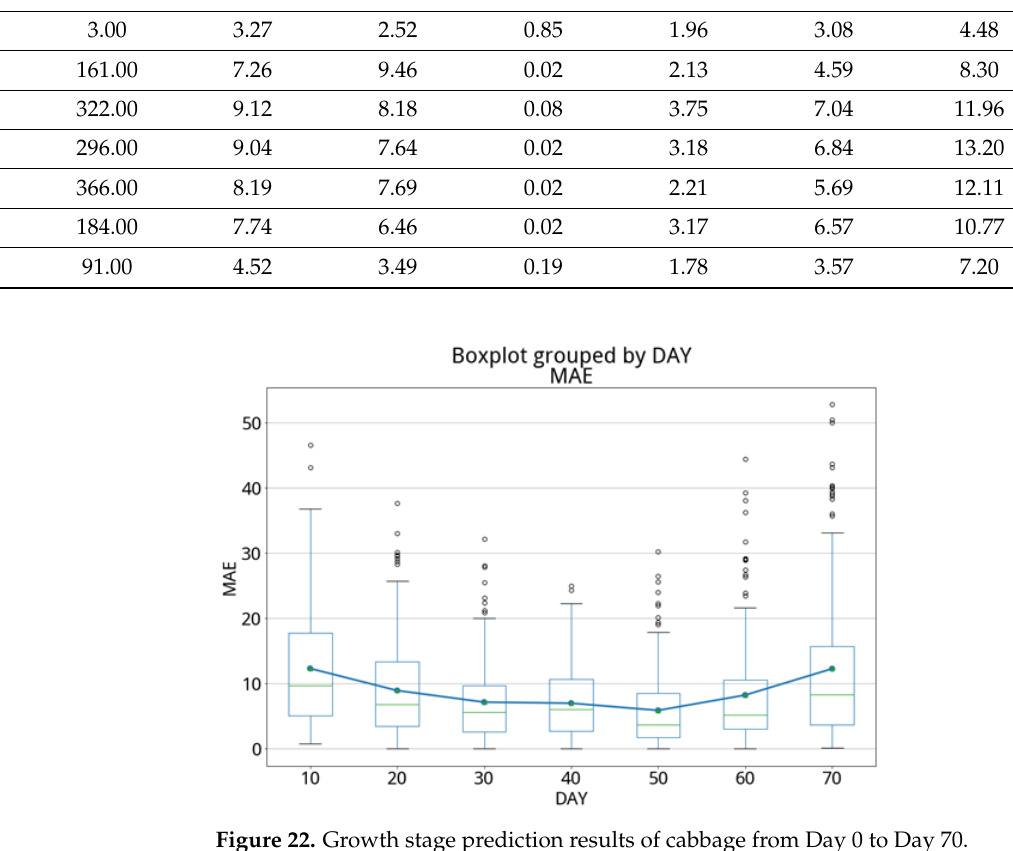
Figure 22. Growth stage prediction results of cabbage from Day 0 to Day 70. Table 9. Cabbage growth stage prediction summary.